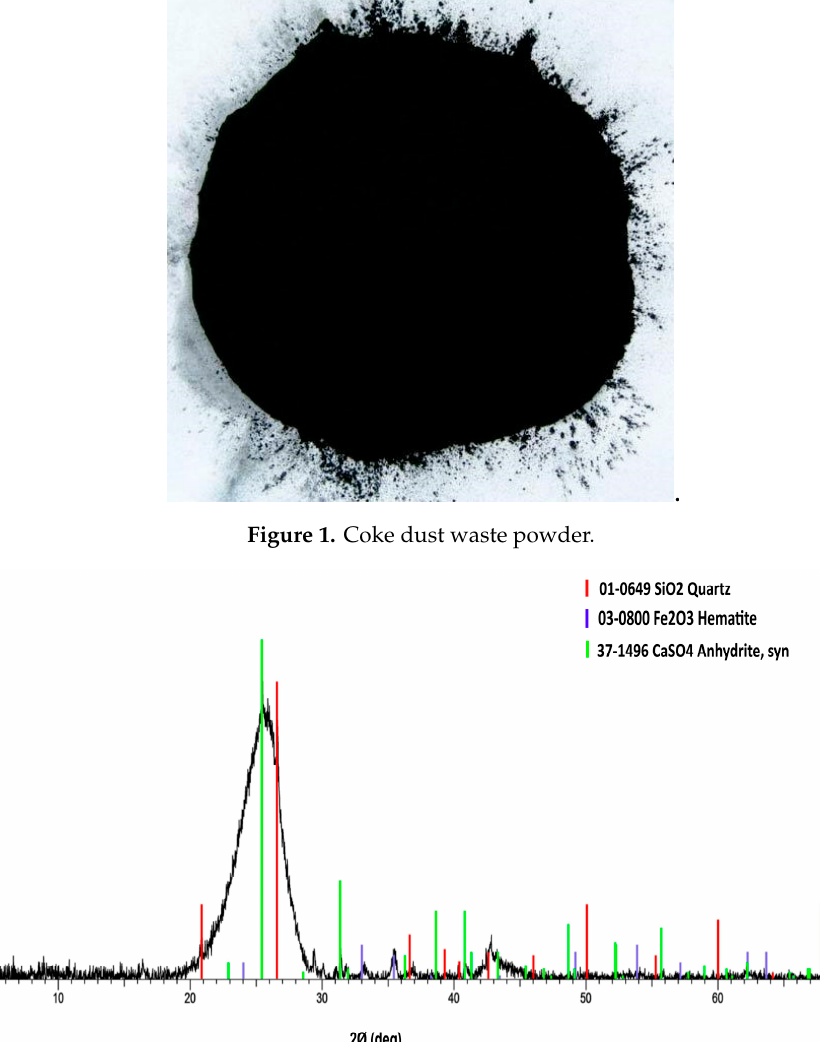
Figure 2. XRD pattern of the coke dust waste. Table 1. Chemical composition of the coke dust waste, determined by XRF (wt %).